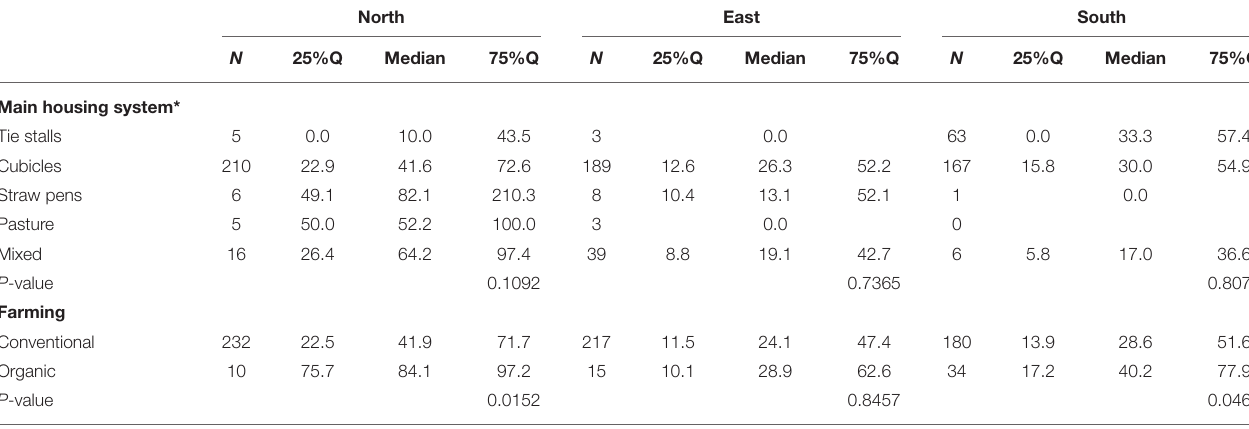
TABLE 3 | Association (Kruskal-Wallis-test) and descriptive analyses of Farmers’ Detection Index depending on farm characteristics (qualitative variables). North East South N 25%Q Median 75%Q N 25%Q Median 75%Q N 25%Q Median 75%Q